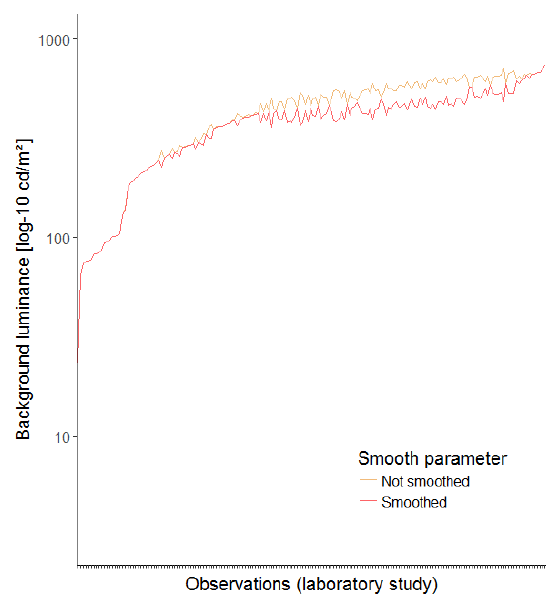
Figure 38. Comparison of the background luminance while varying the smooth parameter with the